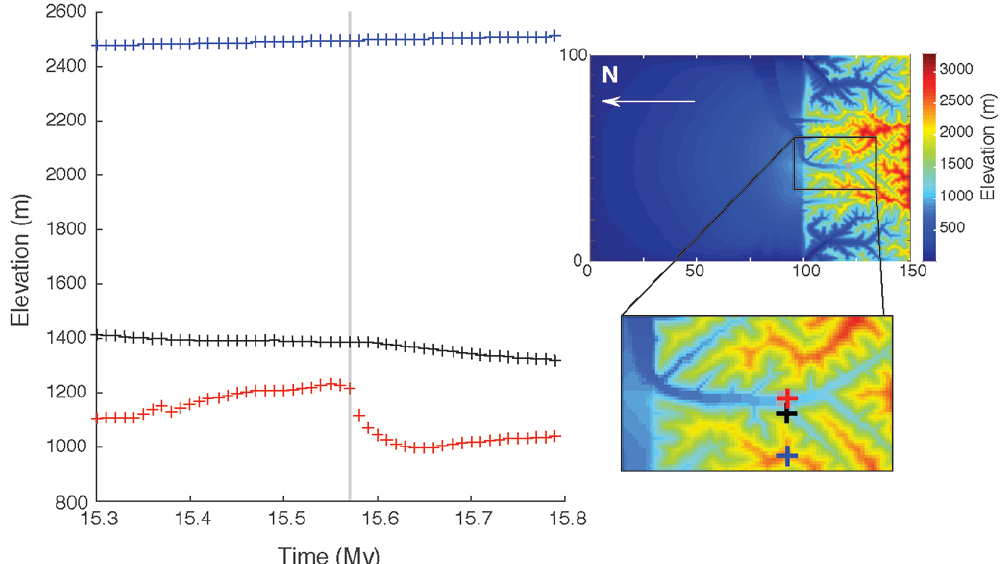
Figure 5. Temporal elevation change of three locations in the mountain: bed of the main feeding river (red crosses), on nearby slope (black crosses) and ridge (blue crosses, see map view in right panel for locations). Following the entrenchment (marked with vertical grey line), the river rapidly incises, increasing (temporarily) the relief, as ridge elevations are not affected by the incision episode. The hillslope response is slow and lags behind that of the